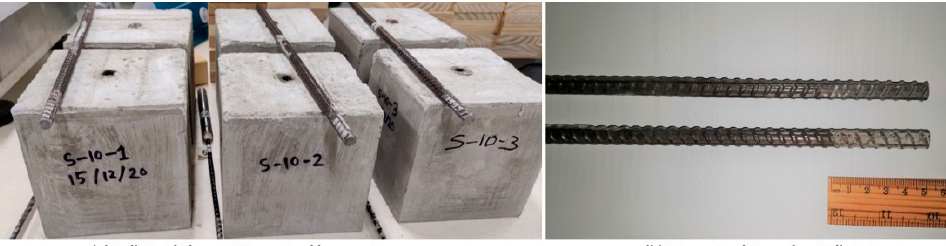
Figure 12 . Pull-out failure of 10-mm basalt FRP bar specimens. Figure 12. Pull-out failure of 10-mm basalt FRP bar specimens.